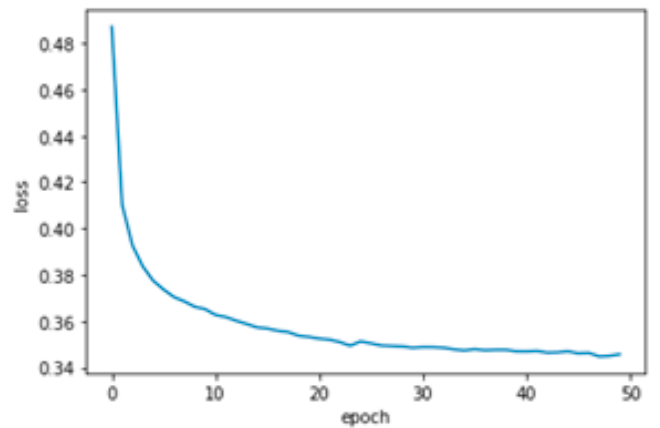
Figure 6. Loss margin result of one experiment.